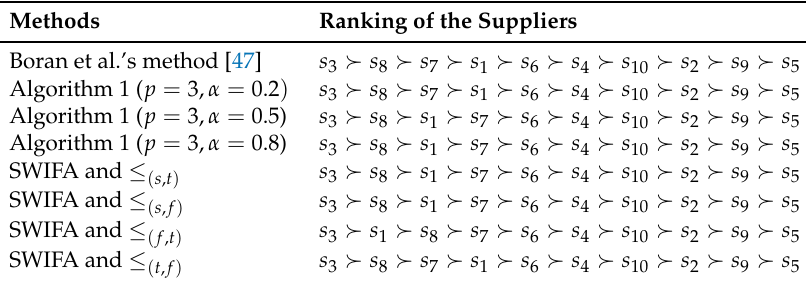
Table 9. Ranking results based on different